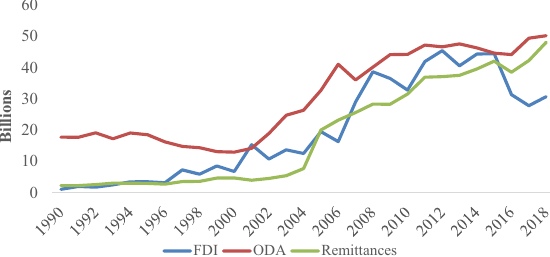
Figure 1. Trend of FDI,